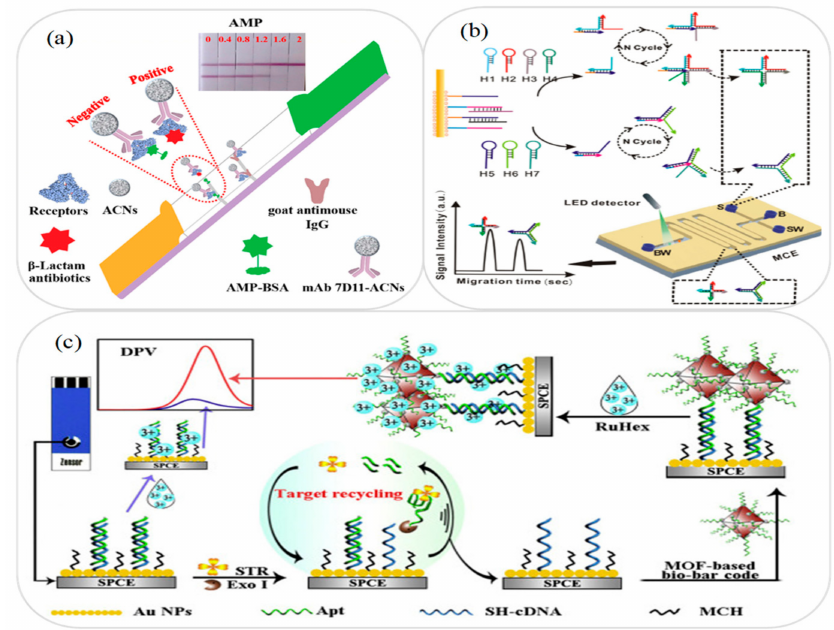
Figure 3. ( a ) Microfluidic lateral flow immunoassay device for detection of 22 β -lactams.